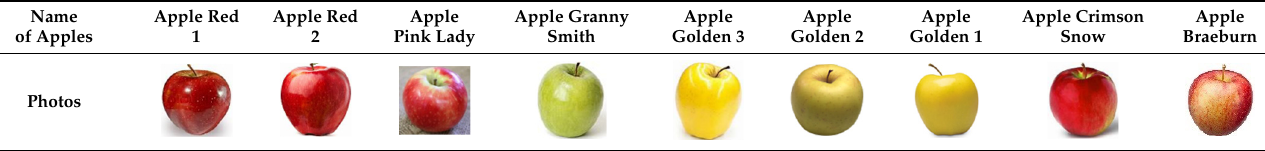
The CC values for the feature of “color” is obtained by comparing to the one with (deep red color).